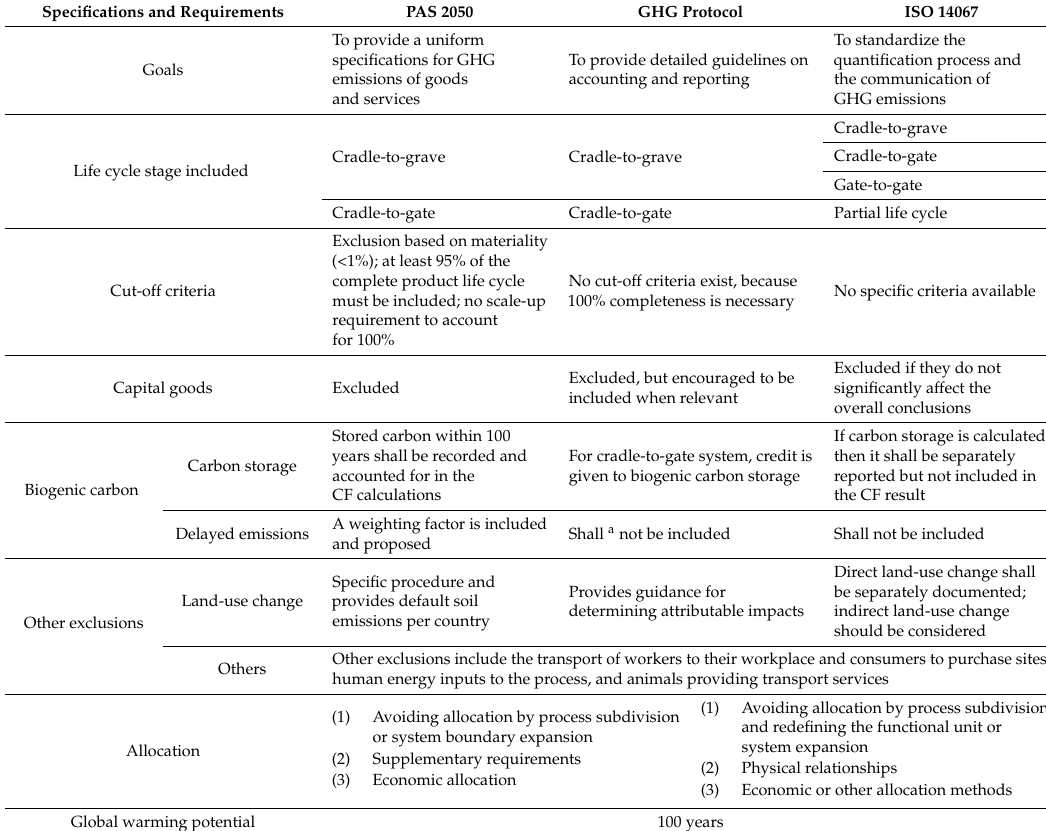
Table 1. An overview of key aspects specified in carbon footprint protocols: Publicly Available Specification (PAS) 2050, Greenhouse Gas Protocol Product Standard (GHG Protocol), and ISO 14067 Carbon Footprint of Products (ISO